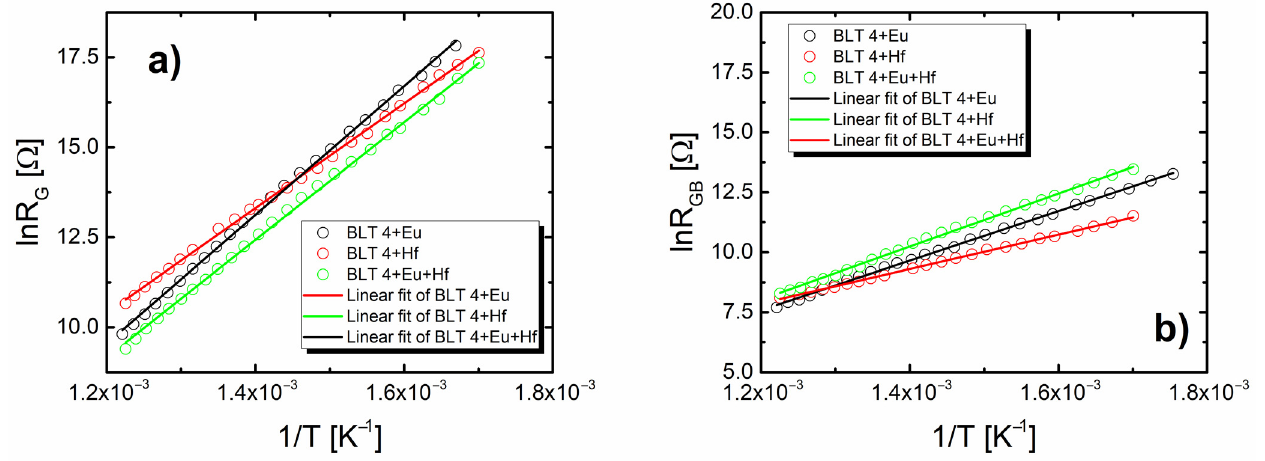
Figure 11. Equivalent circuit used to represent the electrical properties of pure and modified BLT4 ceramics.